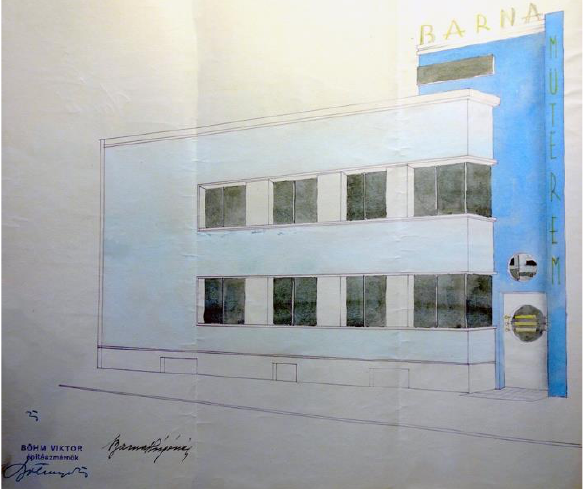
Figure 10. Original façade design of the 16 D é ryn é street former studio and the residential house of the photographer Hug ó Barna. Architect: Victor Bohm, 1932. Source: MNL BAZML IV. 1906/b.